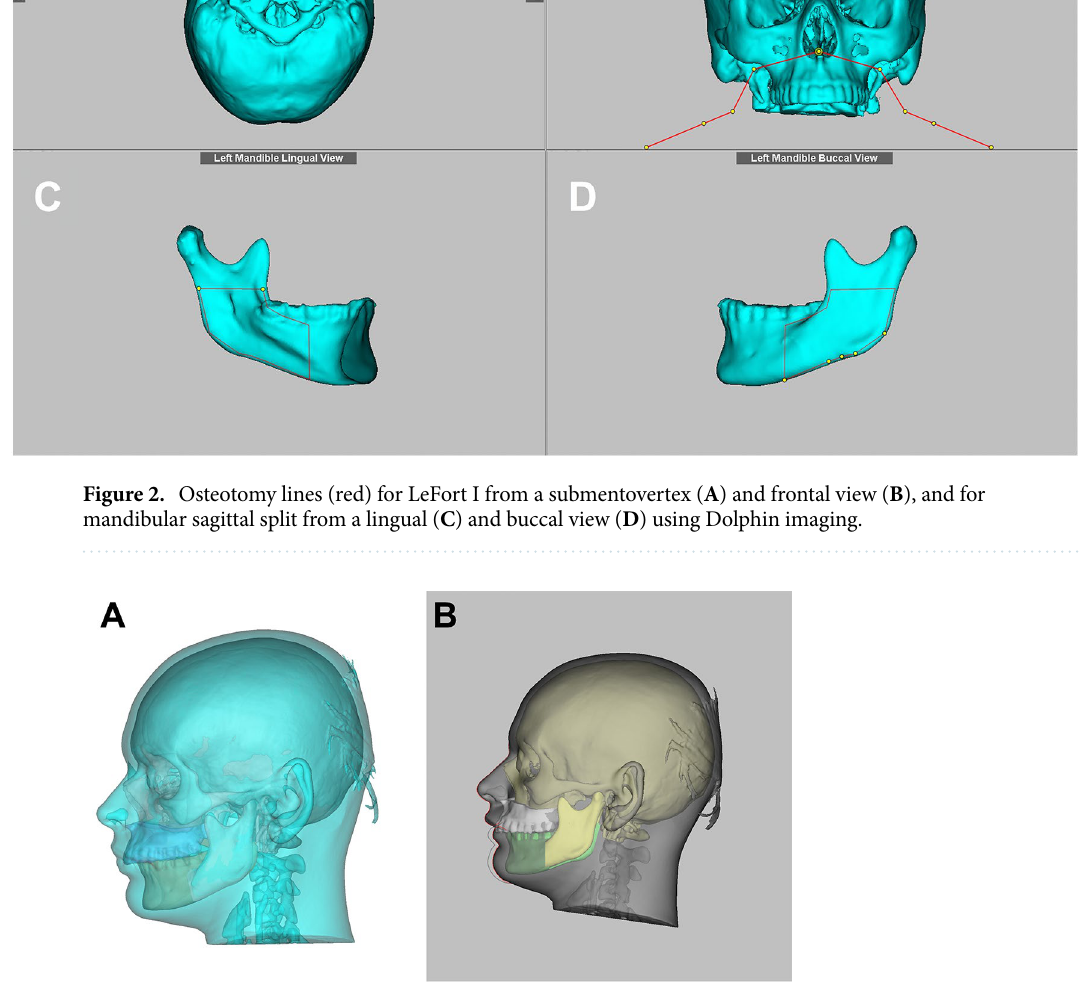
Figure 3. Profile view of the soft tissue simulation for the 7 mm mandibular setback using ProPlan CMF ( A ) and Dolphin imaging ( B ).